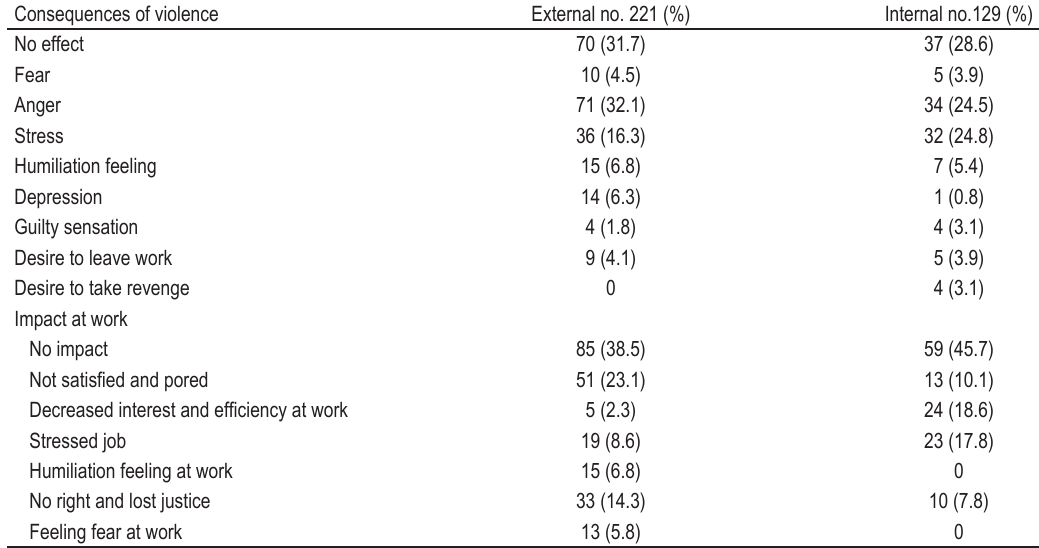
TABLE 5. Consequences of violence on nurses and its impact at work, Minia district hospitals Consequences of